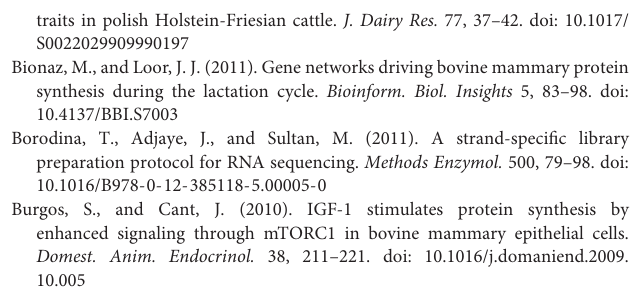
FIGURE S3 | The predicted secondary structures of lncRNAs transcripts and miRNAs sequences. The secondary structure was created by Vienna RNA package RNAfold web (http://rna.tbi.univie.ac.at/). FIGURE S4 | Seven lncRNAs located in the casein genes cluster on bovine genome. Blue and red box represented lncRNA transcripts and the casein genes, respectively. TCONS_0484809 located in the first intron of CSN3 . FIGURE S5 | The expression boxplot for neighbor genes of lncRNAs. The red and blue boxplots represent the gene expression within 100 and 10 k upstream/downstream of lncRNAs, respectively. The green boxplot is the expression of all protein-coding genes. FIGURE S6 | Validation of XLOC_059976 and target gene ( CNTFR ) by qRT-PCR. GAPDH gene was used as housekeeping internal control. Transcript expression was quantified relative to the expression level of housekeeping using the comparative cycle threshold ( (cid:49) CT) method. The data were presented as the mean ± SE ( n = 3). FIGURE S7 | The combine sites between XLOC_059976 and CNTFR. TABLE S1 | The phenotype information of six Chinese Holstein cattle. TABLE S2 | The concentration and quality information of RNA samples. TABLE S3 | The 12 previous GWAS studies for milk protein traits. TABLE S4 | Summary of sequence reads alignment. TABLE S5 | The annotation of lncRNAs with gtf format. TABLE S6 | The annotation of novel genes with gtf format. TABLE S7 | lncRNA sequences blast against NONCODE database. TABLE S8 | The results of differentially expressed lncRNAs, novel genes and protein-coding genes. (a) The differentially expressed lncRNAs results. (b) The differentially expressed novel gene results. TABLE S9 | lncRNAs harboring complete precursors of miRNAs. TABLE S10 | The target prediction between lncRNAs and miRNAs. (a) The target prediction between all lncRNAs and all miRNAs. (b) The target prediction between lncRNAs and milk protein miRNAs. TABLE S11 | Pearson correlations between protein-coding genes and differentially expressed lncRNAs. TABLE S12 | The protein-coding genes within 10 and 100 k upstream and downstream of an lncRNA. (a) The protein-coding genes within 10 and 100 k upstream and downstream of lncRNAs. (b) The prediction of lncRNA- mRNA pairs by both cis and trans . (c) The expression patterns for differentially expressed lncRNA and their differentially expressed neighboring genes. TABLE S13 | Functional enrichment analysis of the protein-coding genes of lncRNAs in cis and trans. (a) The Gene Ontology results of cis and trans target genes using DAVID. (b) The pathway results of cis and trans target genes using IPA. TABLE S14 | The integrate study for differential lncRNA-mRNA